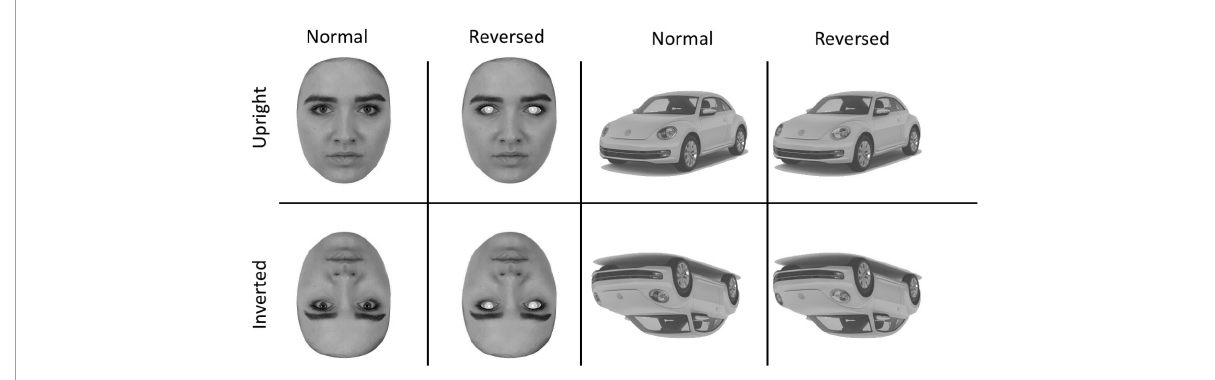
FIGURE1 Sample Stimuli showing the upright (top) and inverted (bottom) versions of the faces and cars The second column shows faces with eye contrast reversed and the fourth column shows the car with the headlights